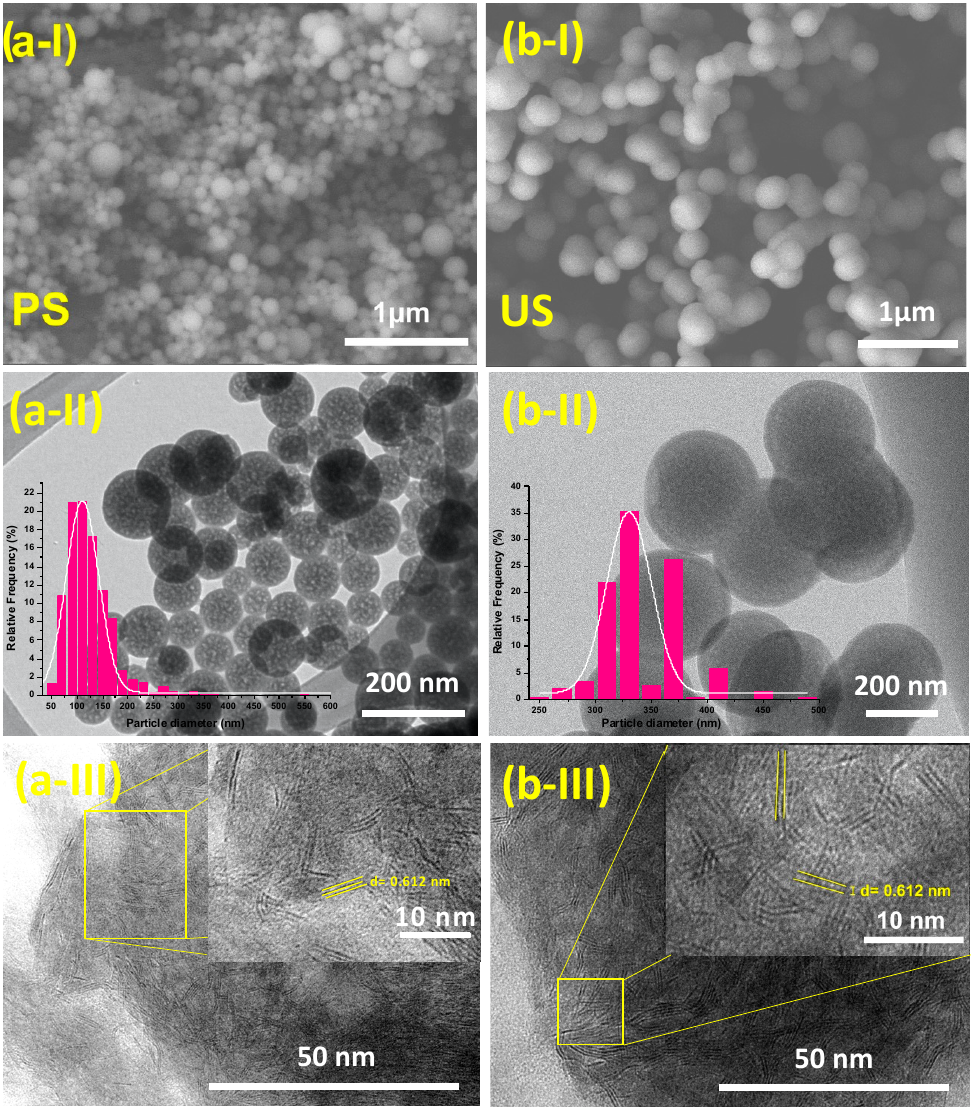
Figure 3. FE-SEM micrographs of PS ( a - I ) and US ( b - I ); TEM micrographs and inset from particle diameter distribution of PS ( a - II ) and US ( b - II ); and HRTEM micrographs of CoMoS/PS catalyst ( a - III ) and CoMoS/US ( b - III ). Table 2. Average length ( L ), layer number ( N ), and f Mo of MoS 2 crystallites of CoMoS